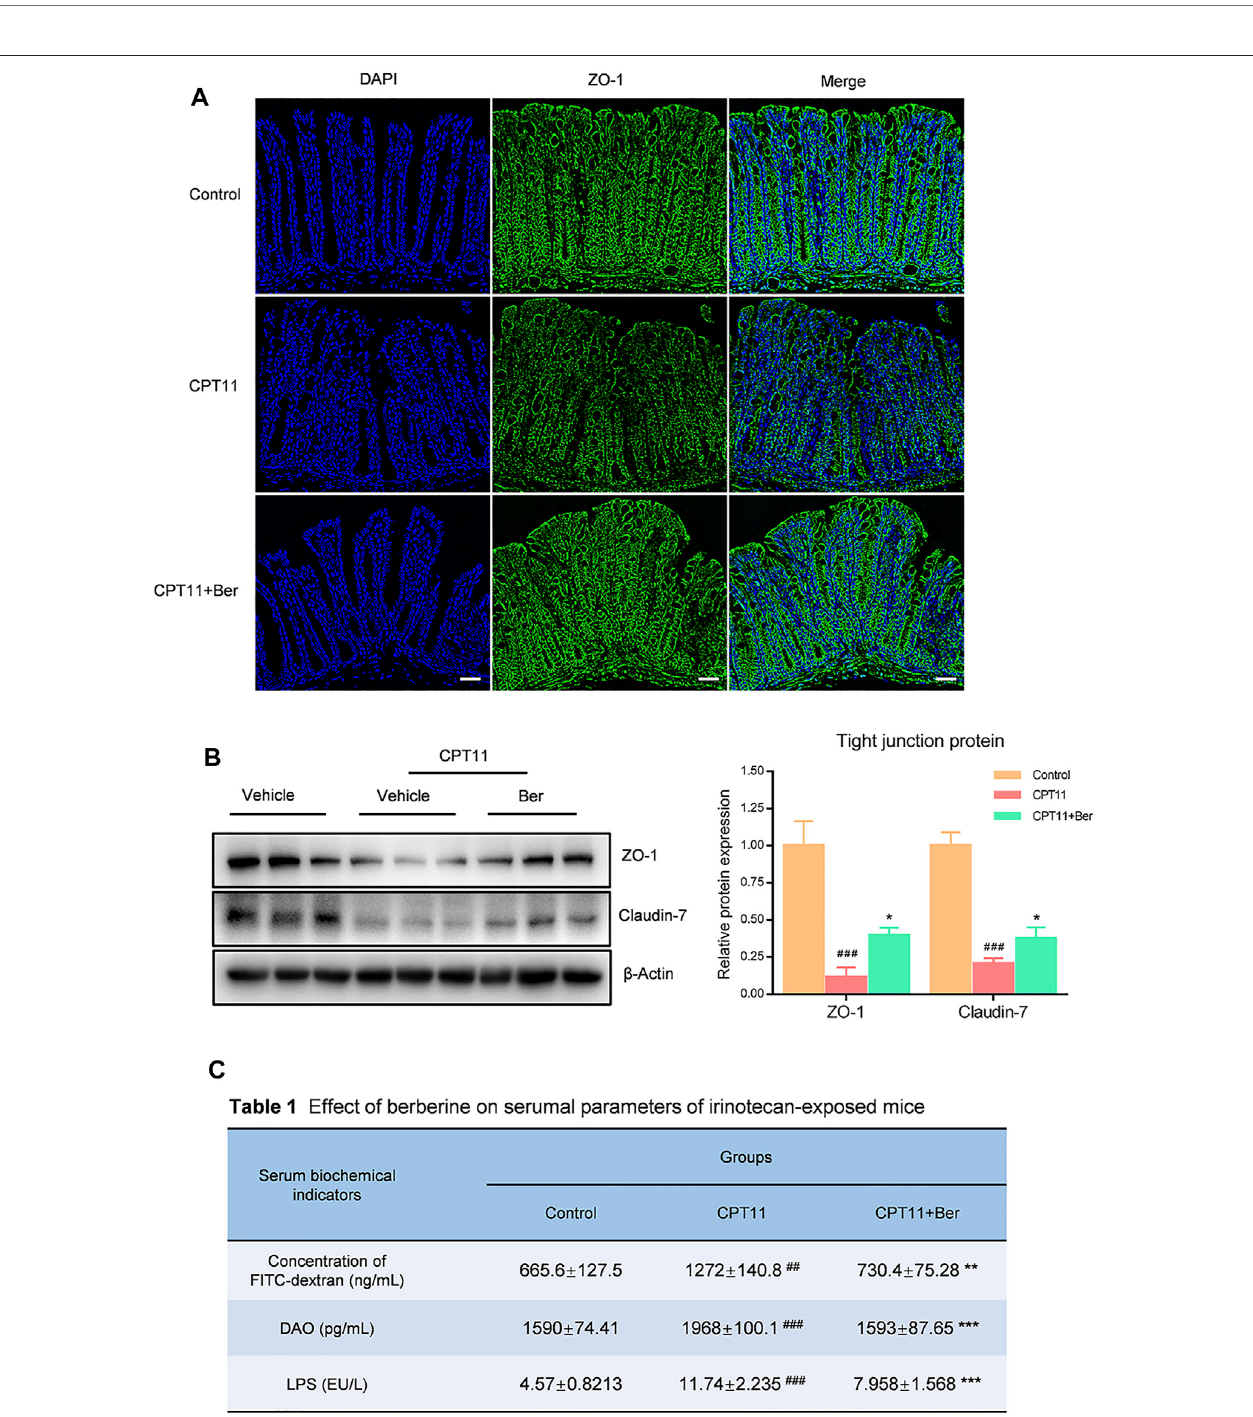
FIGURE3| Berberineprotectedtheintegrityoftheintestinalbarrierinmice withmucositis. (A) Immuno fl uorescence stainingofthecolonictissues forZO-1protein (green). Nuclei were stained with DAPI (blue). (B) The effect of berberine on the expression levels of tight junction proteins (ZO-1 and Claudin-7) in colonic tissues. Representative western blots and quantitative analysis of the proteins. (C) The fl uorescence intensity of FITC-dextran was detected by fl uorescence spectroscopy ( n (cid:2) 4 – 5). The serum levels of LPS and DAO were determined by ELISA. Data are expressed as the mean ± SD ( n (cid:2) 3 per group). ## p < 0.01, ### p < 0.001 vs. the control group; * p < 0.05, ** p < 0.01, *** p < 0.001 vs. CPT11 + berberine treated group.